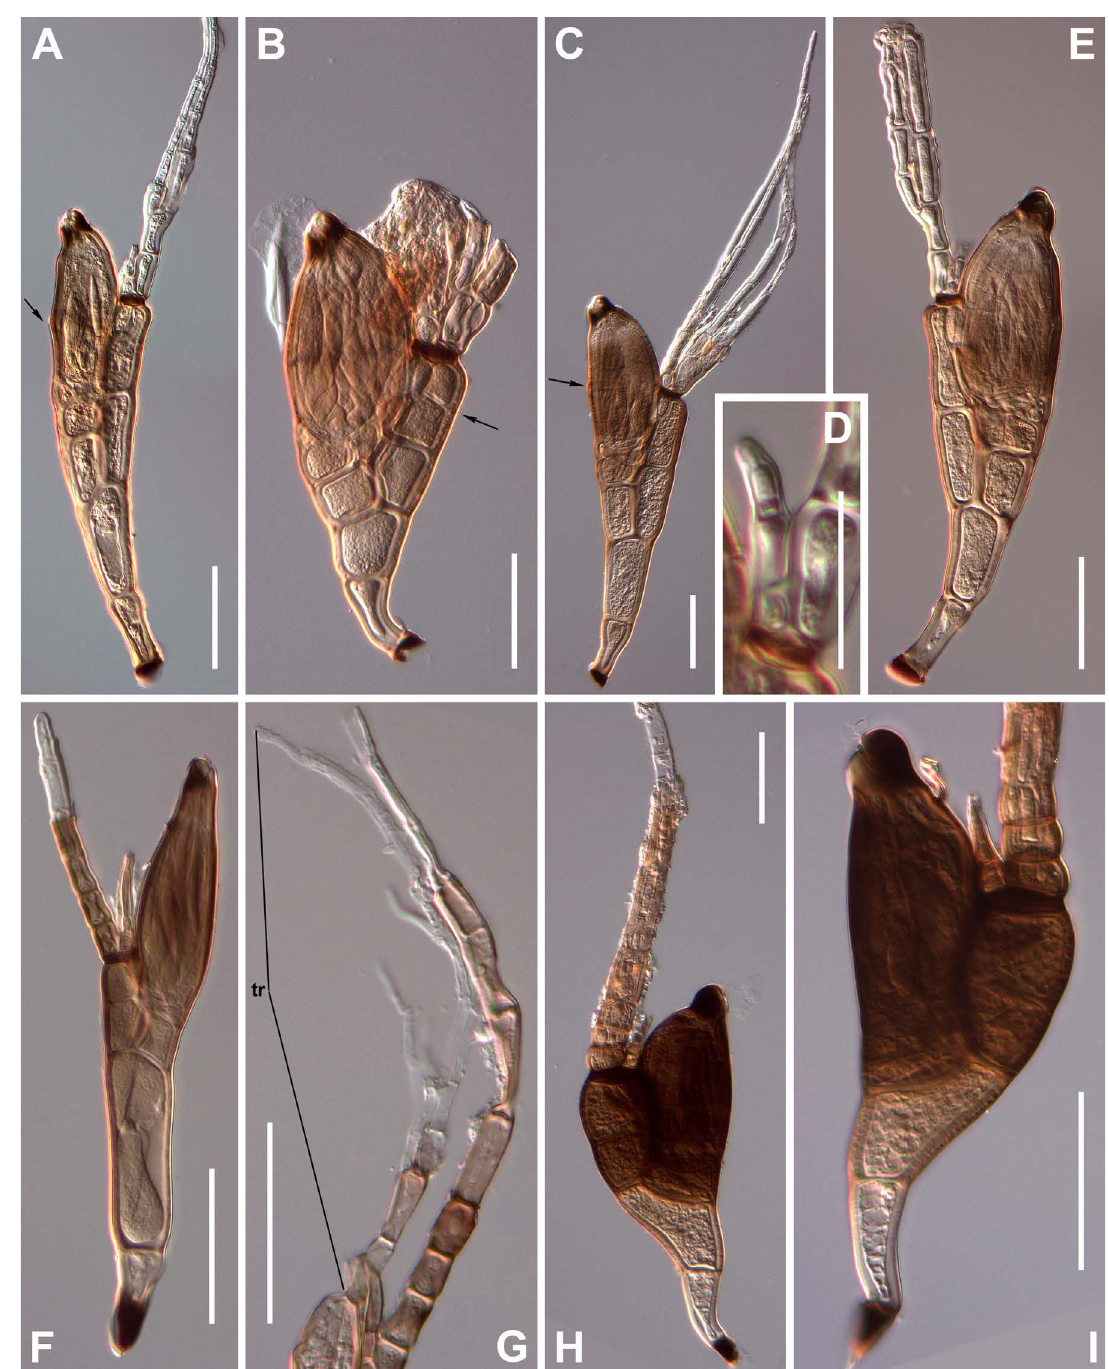
Fig. 44. Laboulbenia spp. A – E . L. stenolophi Speg. Mature thalli except fig. D which represents a detail of the inner appendage. A and C show the perithecial ventral prominence formed by the junction of outer wall cell tiers w and w (arrows). B . Cell IV subdivision is shown (arrow). A – B . From Stenolophus mixtus . 1 2 C . From Stenolophus teutonus . D – E . From Acupalpus flavicollis . – F – G . L. stilicicola Speg. F . Mature thallus. G . Upper part of an immature thallus showing an elongate trichogyne (tr). – H – I . L. thaxteri Cépède & F.Picard. Mature thalli. Scale bars: A–C, E–I = 50 µm; D = 25 µm. Photographs from slides ZMUC C-F-122606 (A), ZMUC C-F-123150 (B), ZMUC C-F-122707 (C), ZMUC C-F-122974 (D–E), ZMUC C-F-123727 (F–G), ZMUC C-F-123102